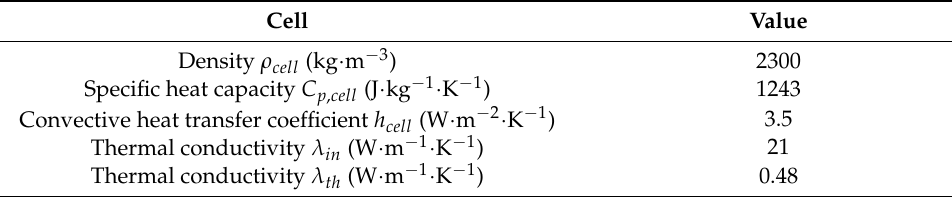
Figure 2. ( a ) Grids of the cell; ( b ) grids of the model used for calculation; ( c ) temperature distribution on the cell at the end of 1.5 C discharge. Table 3. Material parameters of the cell [32].